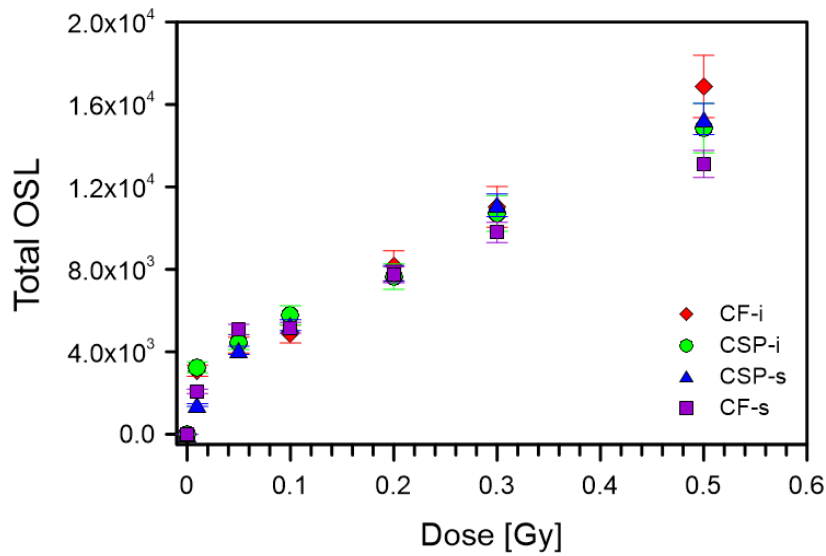
Figure 8. Dose – response characteristics measured in the range of 0.01 – 0.5 Gy for CSP-i, CF-i, CSP- Figure 8. Dose–response characteristics measured in the range of 0.01–0.5 Gy for CSP-i, CF-i, CSP-s, CF-s samples. s, CF-s samples.